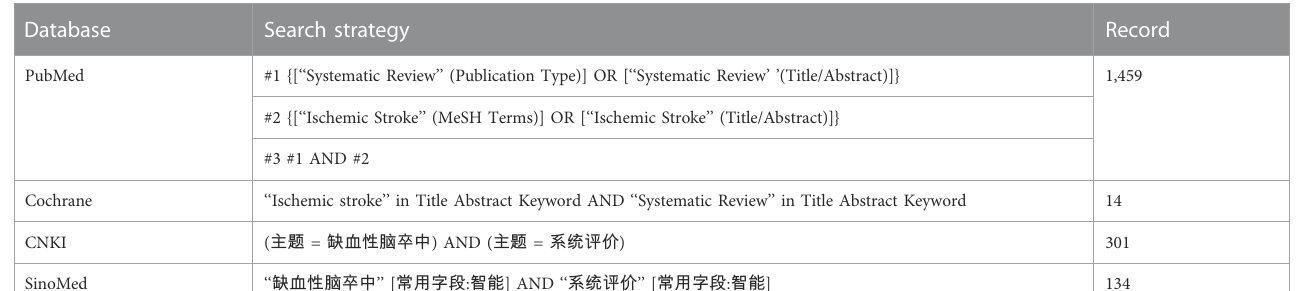
TABLE 1 Search strategy of each